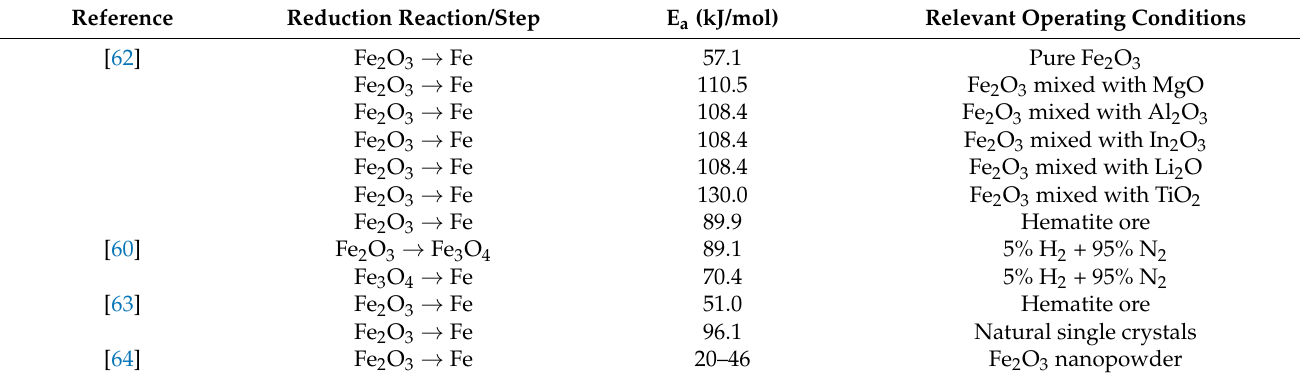
Table 1. The amounts of apparent activation energy related to the reduction of iron oxides by hy- drogen.